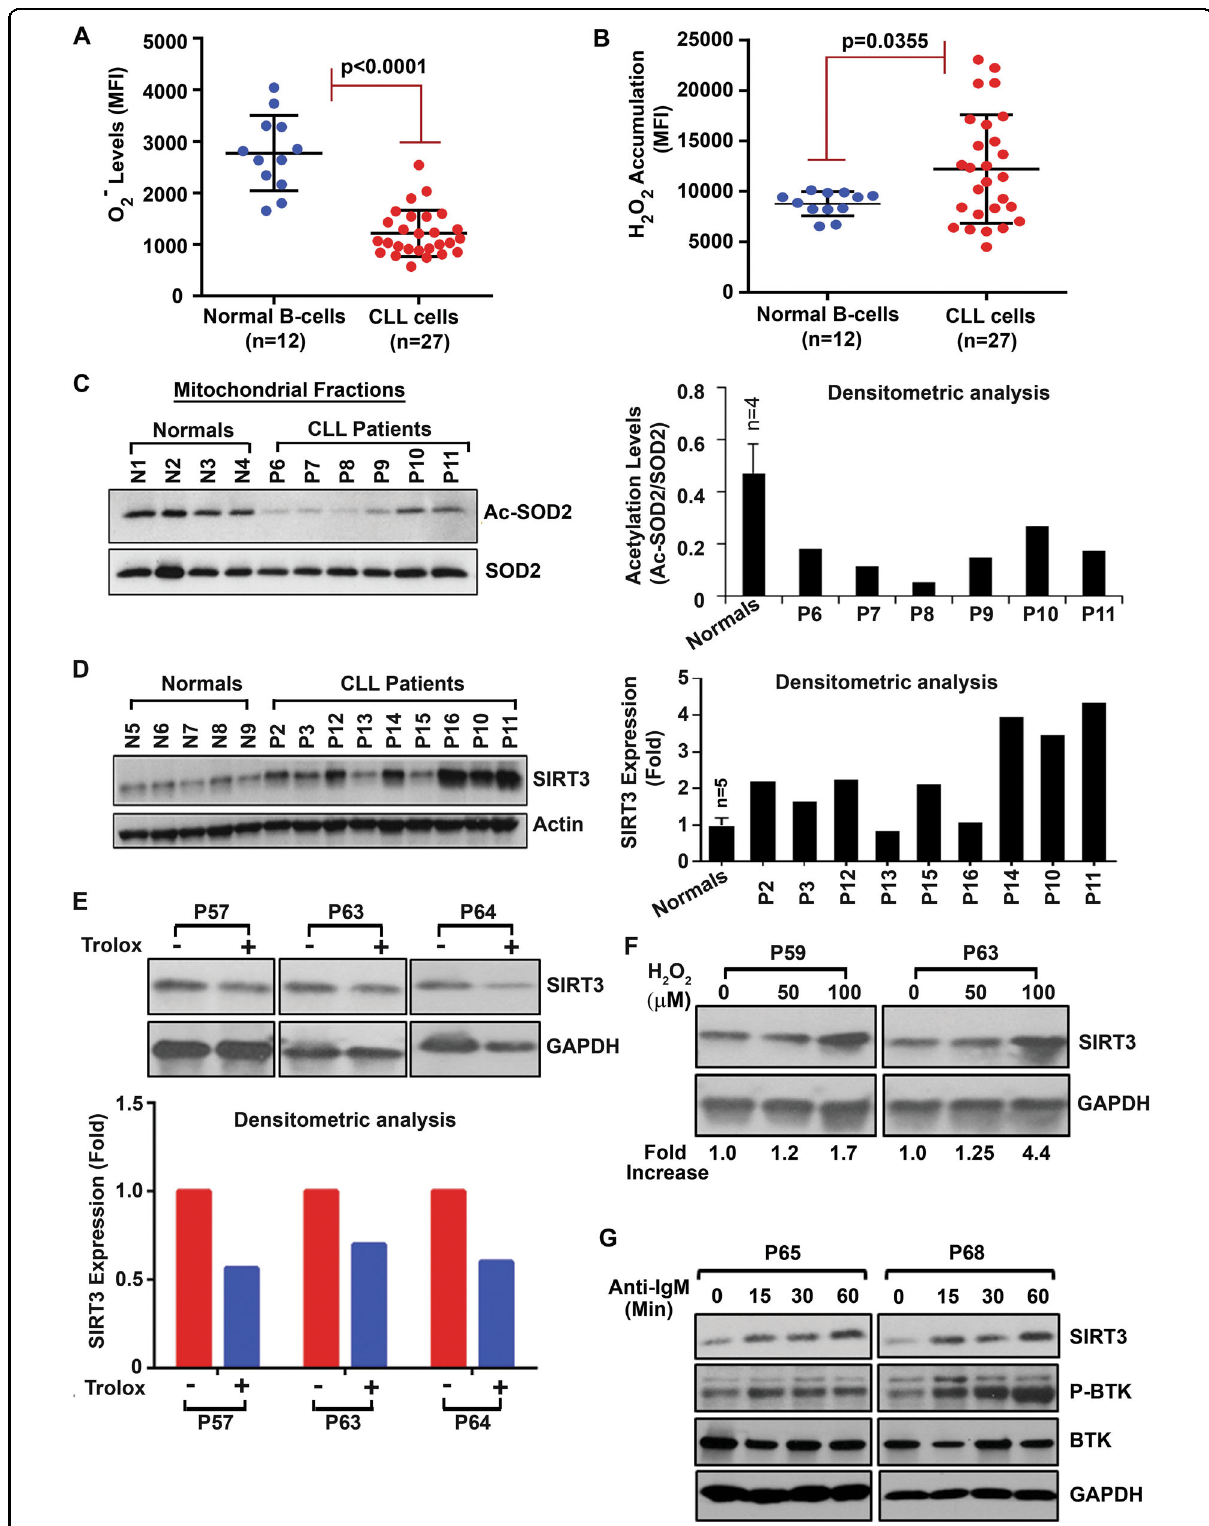
Fig. 1 (See legend on next